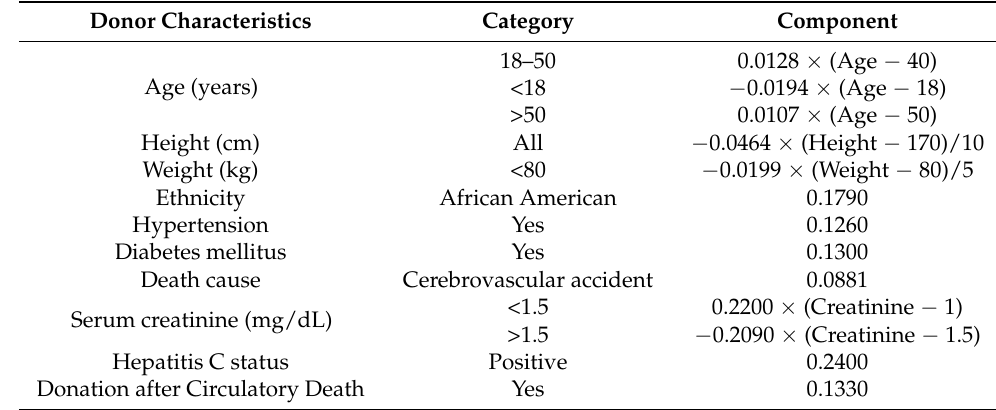
Table A1. Donor characteristics and coefficients used for KDRI